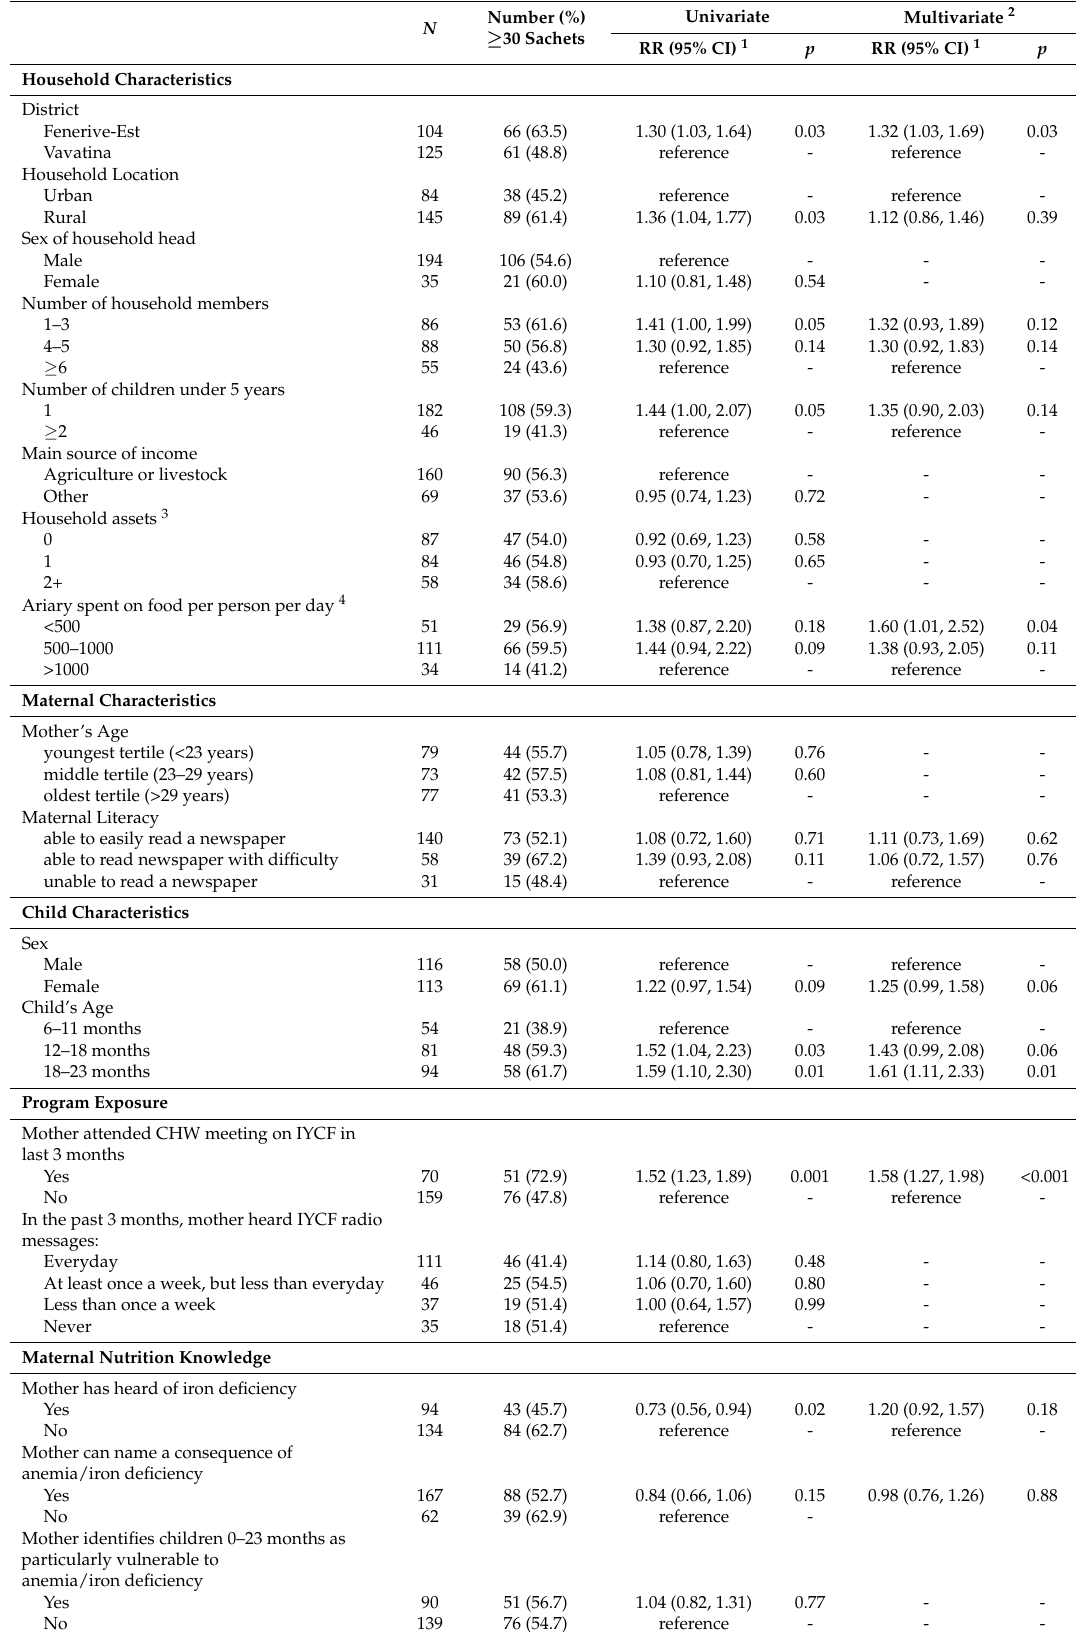
Table 5. Predictors of consumption of ≥ 30 sachets of MNP among MNP